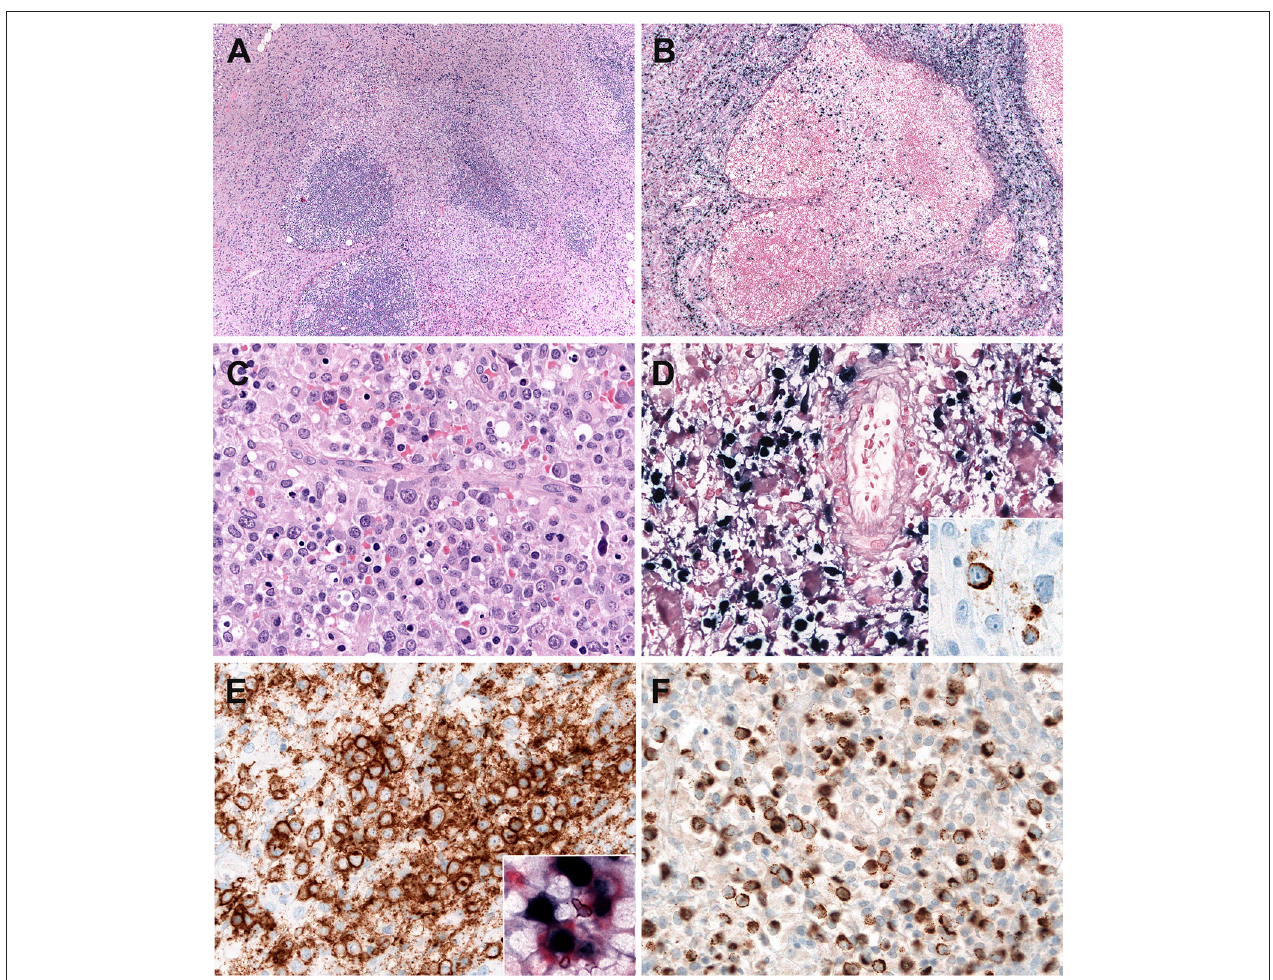
FIGURE 2 | Systemic Epstein-Bar virus (EBV)-positive T-cell lymphoma of childhood. (A) Lymph node with partial preservation of the architecture with depleted germinal centers and expansion of the interfollicular area (H&E, 50 × ); (B) Many of the lymphoid cells in the interfollicular area are EBV-positive, as demonstrated by in situ hybridization for EBV-encoded small RNA (EBER) ( in-situ hybridization 100 × ); (C) The neoplastic cells are mostly medium to large-sized cells with irregular nuclei. Note the presence of apoptosis (H&E, 400 × ); (D) Many cells are EBER positive ( in-situ hybridization, 400 × ). LMP1 is positive indicating an EBV latency type 2 (immunohistochemistry, insert, 400x); (E) The neoplastic cells are CD8 positive (immunohistochemistry, 400x). Double stainings show that the CD8-positive cells (red) are EBER-positive (Black) (Immunohistochemistry and in situ hybridization, insert, 400x) (F) TIA1 is positive in the infiltrating cells (immunostaining, 400 ×